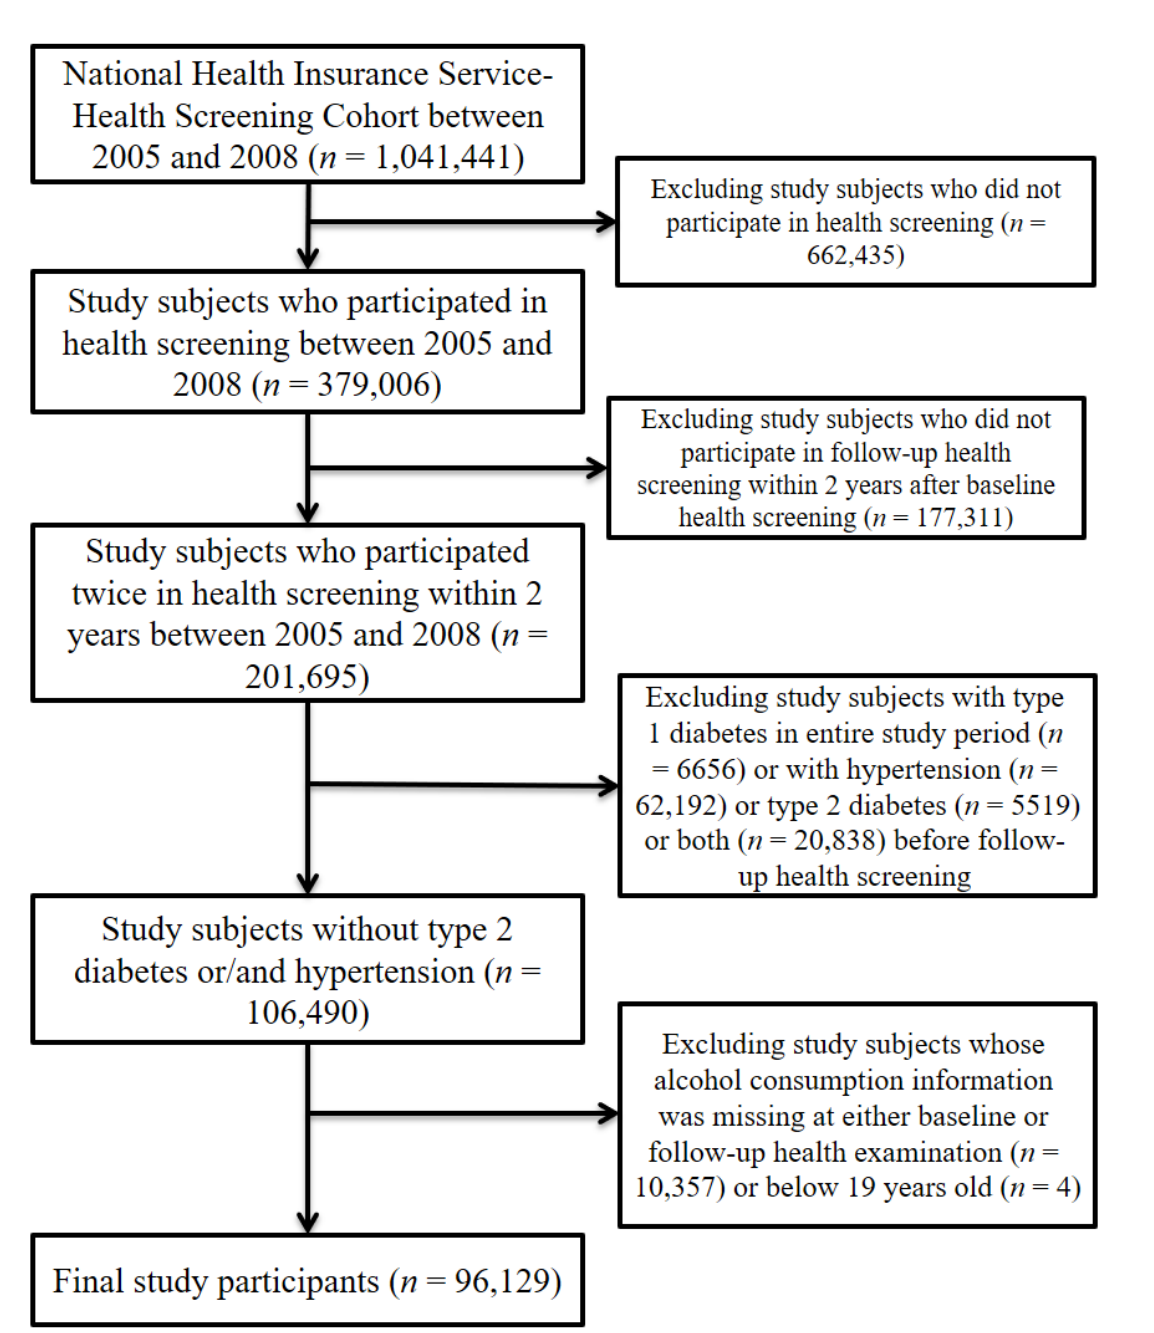
Figure 1. Flow chart of the study participants.